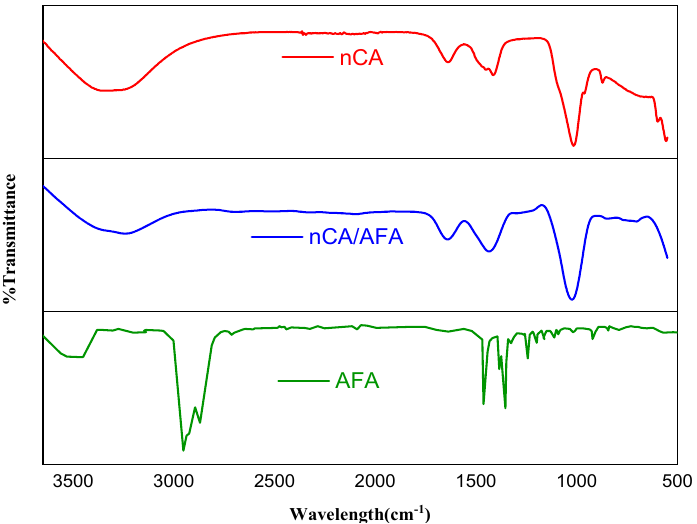
Figure 3. FTIR spectra for nCA (red), nCA/AFA (blue), and AFA (green). The transmittance changes due to afatinib loading into nCA are mentioned in the green box.